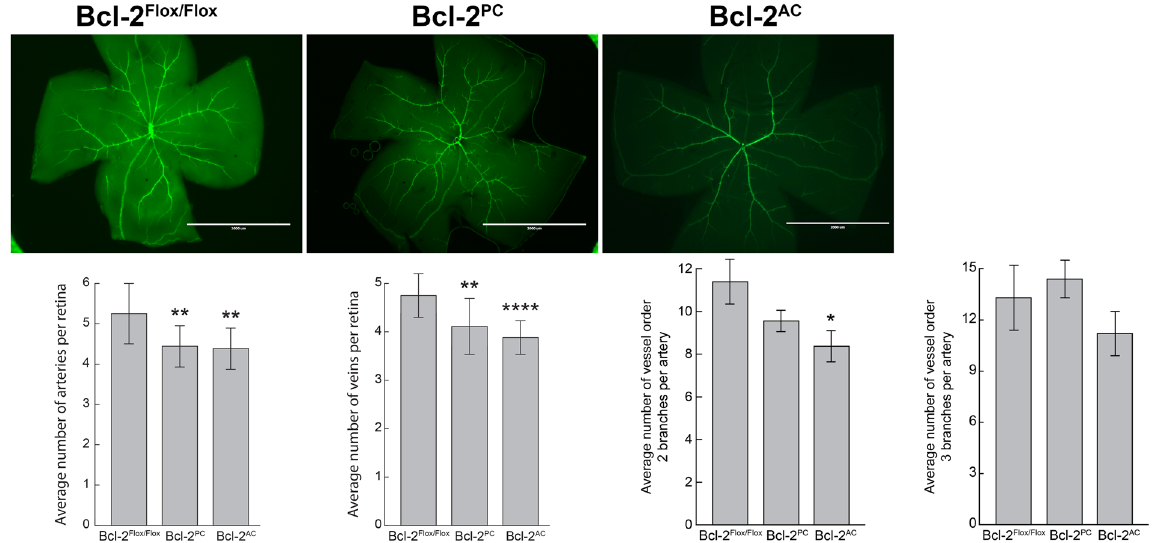
Figure 2. Decreased numbers of retinal arteries and veins in Bcl-2 PC and Bcl-2 AC mice. Retinas from P21 Bcl-2 Flox/Flox , Bcl-2 PC and Bcl-2 AC mice were wholemount stained with anti- α -smooth muscle actin to identify major arteries. The number of arteries and veins per retina were quantified. The average number of vessel order 2 branches and vessel order 3 branches per artery was determined ( * P < 0.05, ** P < 0.01, *** P < 0.001, **** P < 0.0001; n = 8). Scale bar = 2000 µ m. Please note mice conditionally lacking Bcl-2 in pericytes or astrocytes have decreased numbers or retinal arteries and